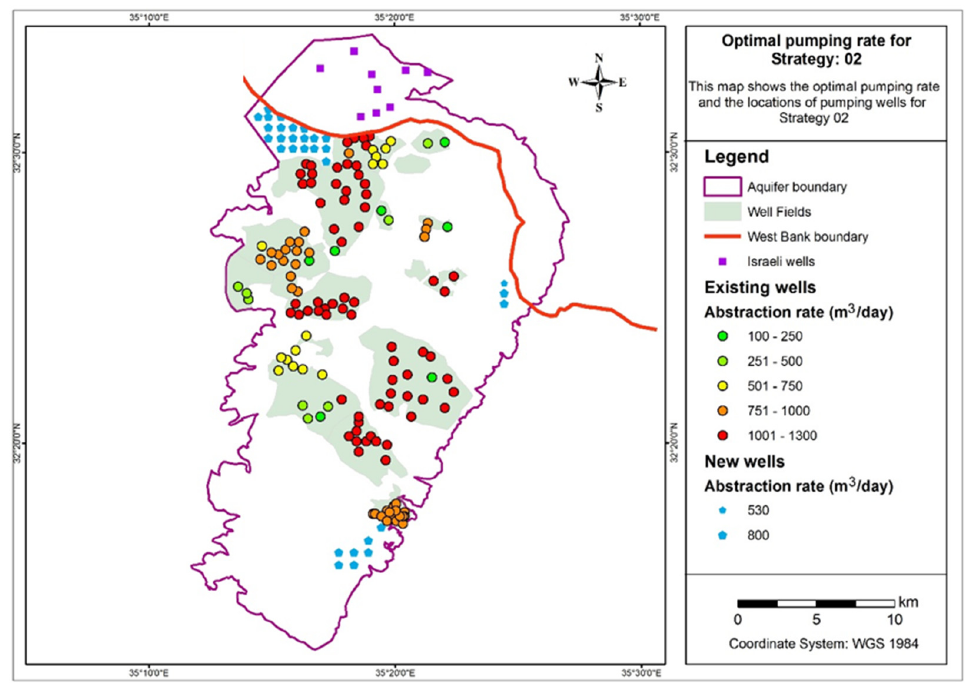
Water 2023 , 15 , x FOR PEER REVIEW Figure 21. Wells distribution and water balance results for Strategy 02. Figure 21. Wells distribution and water balance results for Strategy 02.